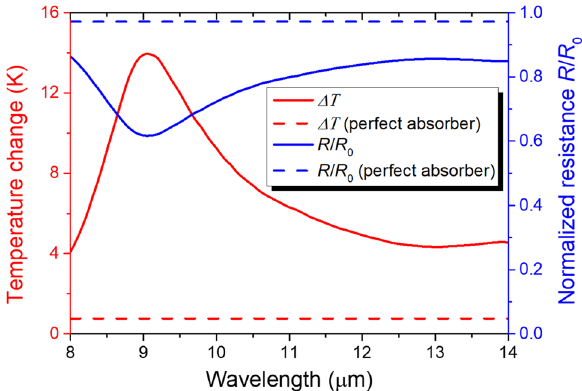
Figure 2. Average temperature change ΔT of the VO 2 gap in the dimer under the 5 nW/μm 2 LWIR irradiation (red solid line) and the corresponding end-to-end resistance normalized by the room temperature resistance R / R 0 (blue solid line). For comparison, average temperature change of a perfect absorbing VO 2 film with the same thermal time constant (red dashed line) and the film’s normalized resistance (blue dotted line) are also displayed.